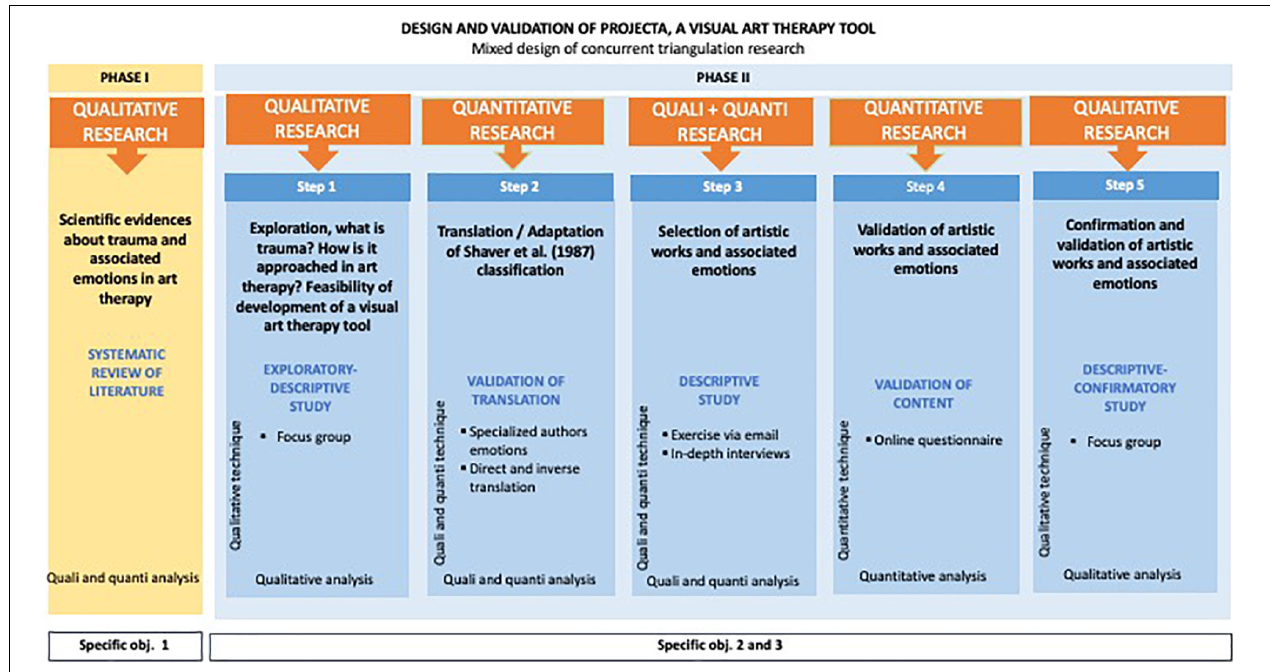
FIGURE 1 | Mixed concurrent triangulation research